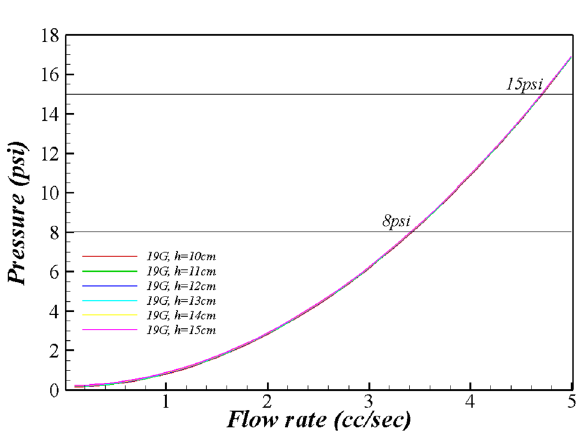
Figure 1. Flow rate range by syringe gauge.